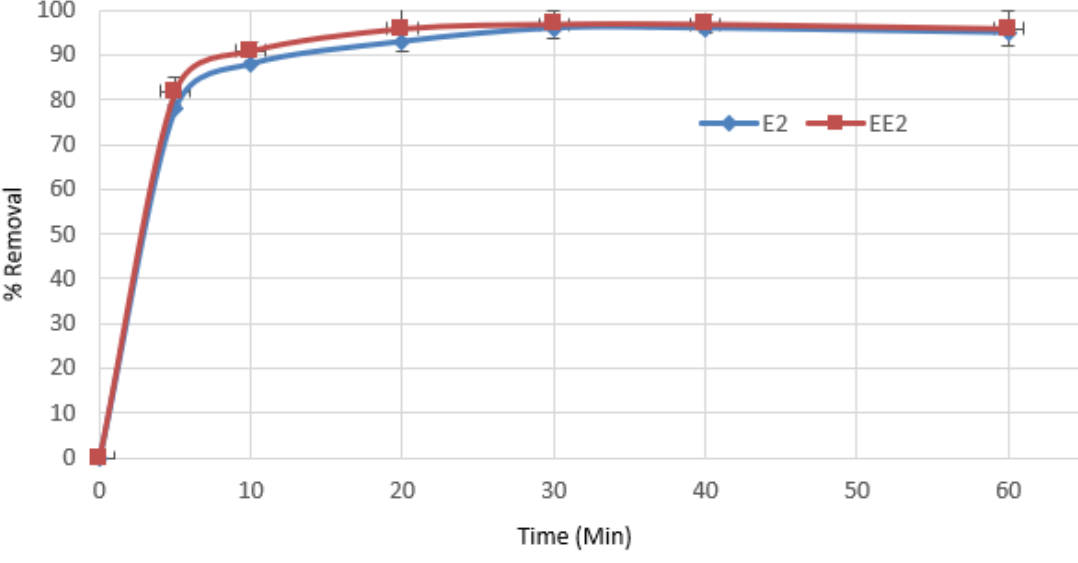
Figure 3. Removal of E2 and EE2 by PMPS particles at varying times and at a temperature of 25 °C (Error bars represent the standard deviation of the mean of the duplicates).